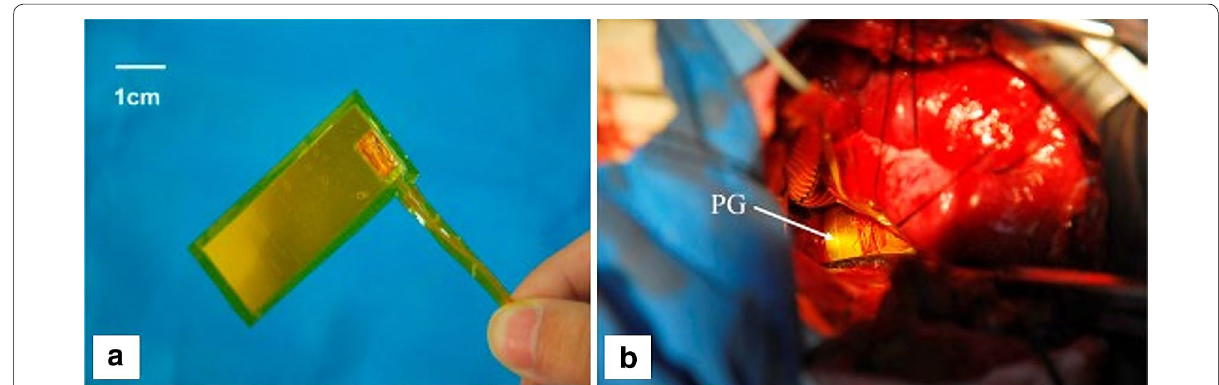
Fig. 6 a PG picture wrapped in PI tape. b PG implanted in the aorta (Reproduced with permission from Ref. [49], Copyright © 2015 Elsevier Ltd. All rights reserved)